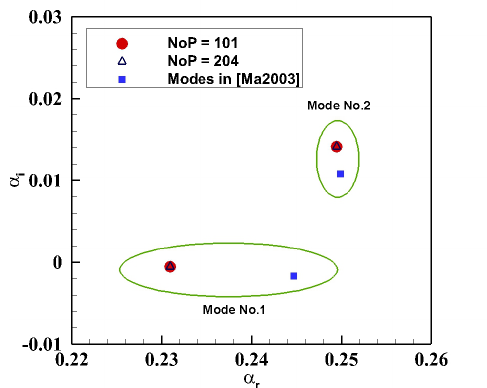
Figure 2. Identified discrete modes in current and the past work (Figure 6,